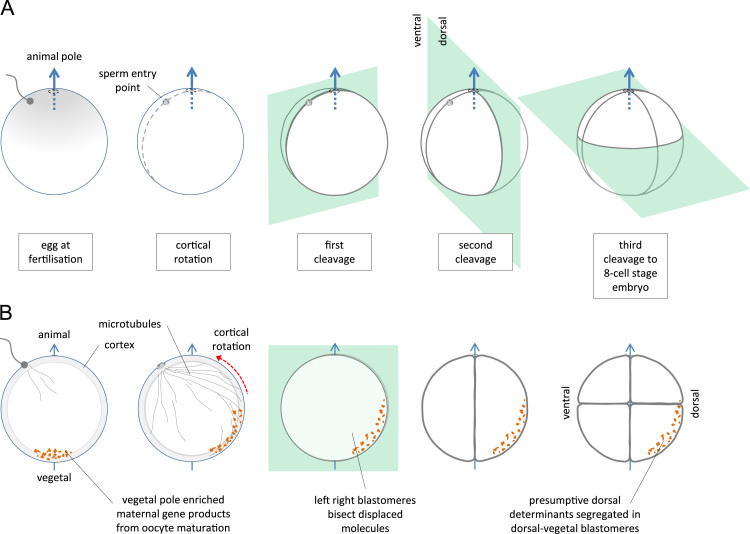
Cortical rotation and the segregation of maternal gene products in the cleavage stage embryo. A. Orientation of early cell divisions. The first cleavage plane is determined by the sperm entry point (SEP) and the animal–vegetal (A–V) axis. The second cleavage is orthogonal to the first but still contains the A–V axis; dorsal blastomeres are defined in the hemisphere opposite the SEP. The third cleavage is slightly above the equator. B. Displacement of maternal gene products. The egg contains vegetally localized maternal gene products. A microtubule network is set up at fertilization and the outer layer, or cortex, of the single cell embryo rotates to displace the vegetal cortical region away the SEP. Maternal gene products are displaced by movement with the cortex or by vesicle trafficking into the presumptive dorsal hemisphere, and are further segregated by subsequent cell divisions.